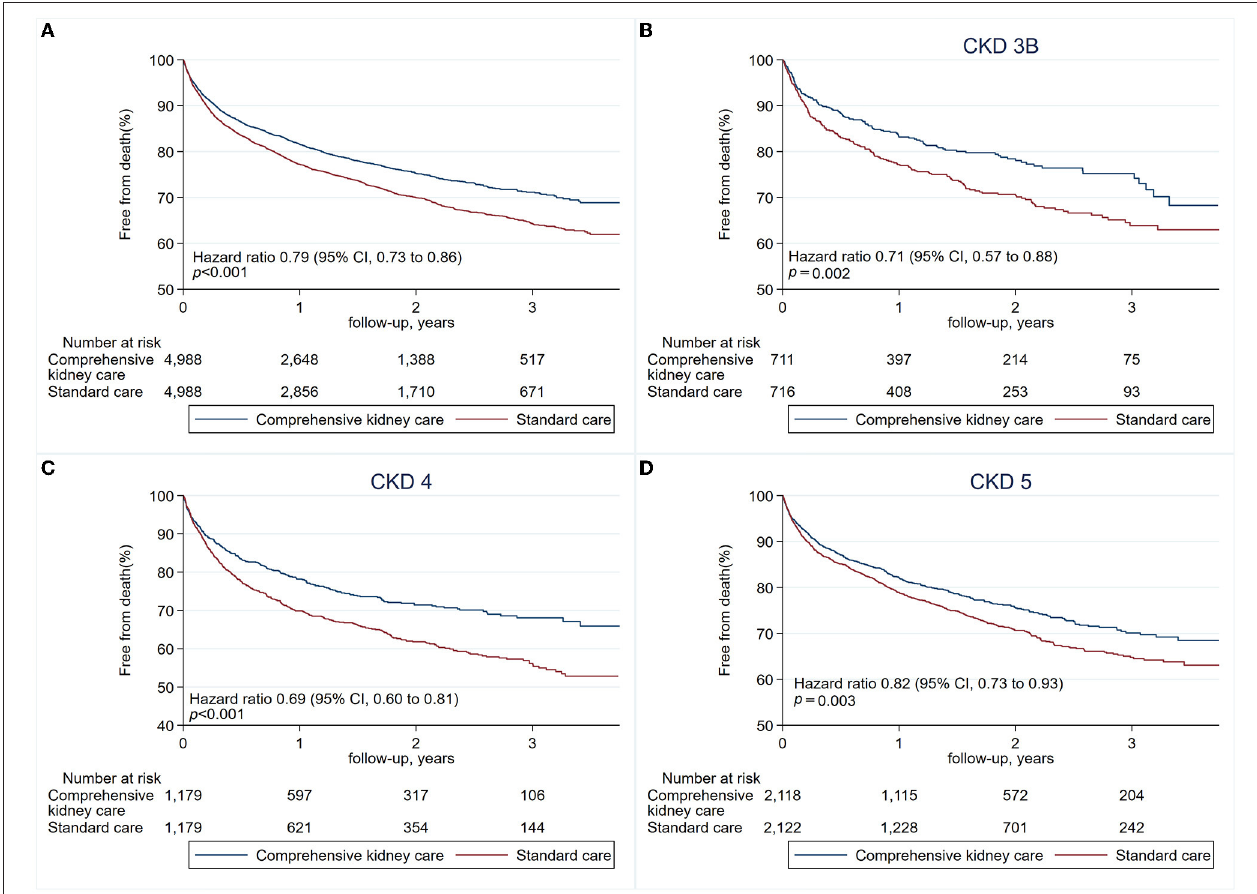
FIGURE 3 | Risks of all-cause mortality. The second primary outcome is the risk of all-cause mortality (A) , estimated with the Kaplan–Meier method. Hazard ratios, confidence intervals, and P -values were estimated with the Cox proportional-hazards regression models. Risk of mortality when stratified according to chronic kidney disease (CKD) stage 3B (B) , CKD stage 4 (C) , and CKD stage 5 (D)